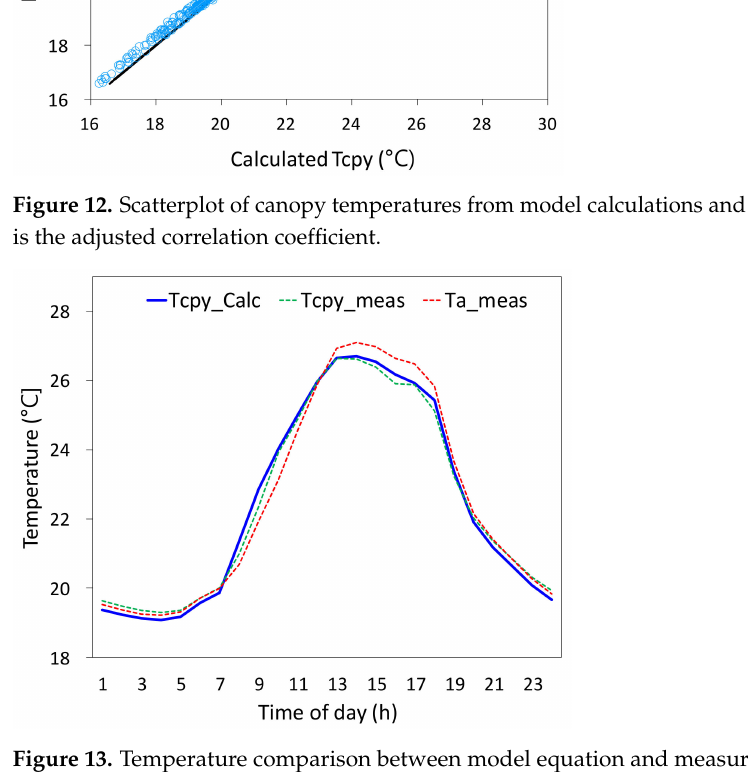
Figure 13. Temperature comparison between model equation and measurements. Tcpy_Calc is the calculated temperature of the canopy, Tcpy_meas are the temperature measurements of the canopy, and Ta_meas are the air temperature